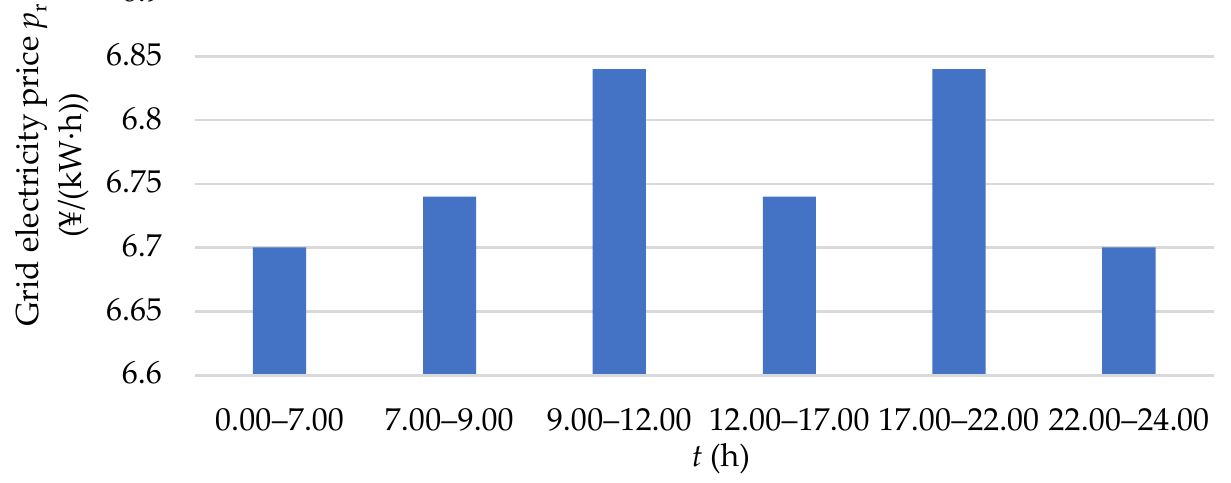
( c ) Figure 12. The change curves of variables of the system under TOUP of the whole day and variable load condition: ( a ) change curves of each DG’s ICR; ( b ) change curves of each DG’s active output and grid output power; ( c ) change curves of the cumulative sum of each DG’s active output and grid output power as well as total demand power. It can be known from Figure 12 that the system is in the initial zero-response state at 0–7 h and the system is in the stable state before 0 h on account of the constant electricity price. In the remaining five periods, the changes of the electricity price of periods and total demand power are rapidly responded by the ICR and active output of each DG, so that the ICR of each DG is converged to the grid electricity price at diverse periods. Meanwhile, the total operation cost of the system is minimized. After a transient dynamic process, the changed total power demand can be met by the accumulation of the DGs’ active output and grid output power. For example, the ICR of each DG is quickly converged to 6.74 ¥/(kW·h) within 7–9 h, and the total power consumption of 125 kW can be satisfied by active output of each DG and output power of the grid. The dynamic response speed is fast and the overshoot is small, too. As can be seen from Figure 12b, since the total power demand has suddenly increased at the peak period, the active output of each DG is slowly raised. Thus, a reverse-peak regulation has occurred in the output power of the grid to meet the power demand, depicting a tendency of the sudden increase at first and then